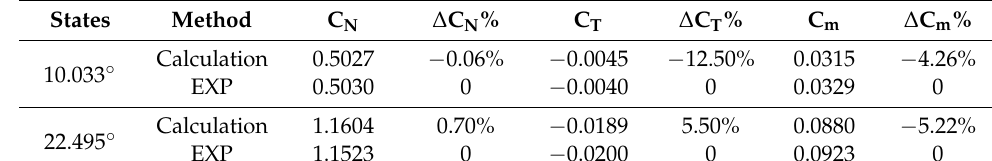
Figure 2. The grid topology of LSSDW: ( a ) Volume grid; ( b ) Surface grid of LSSDW. Table 2. Forces results of Exp and CFD.